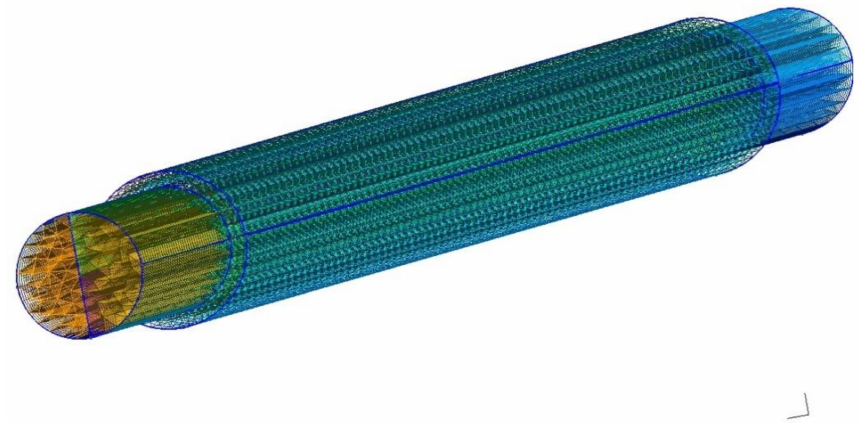
Figure 1. Image of the 3D model for the Ge NW. The nanowire is entirely made of germanium, with electrical contacts on the surface of front and back ends. Triangular shapes indicate the 3D mesh used for volume